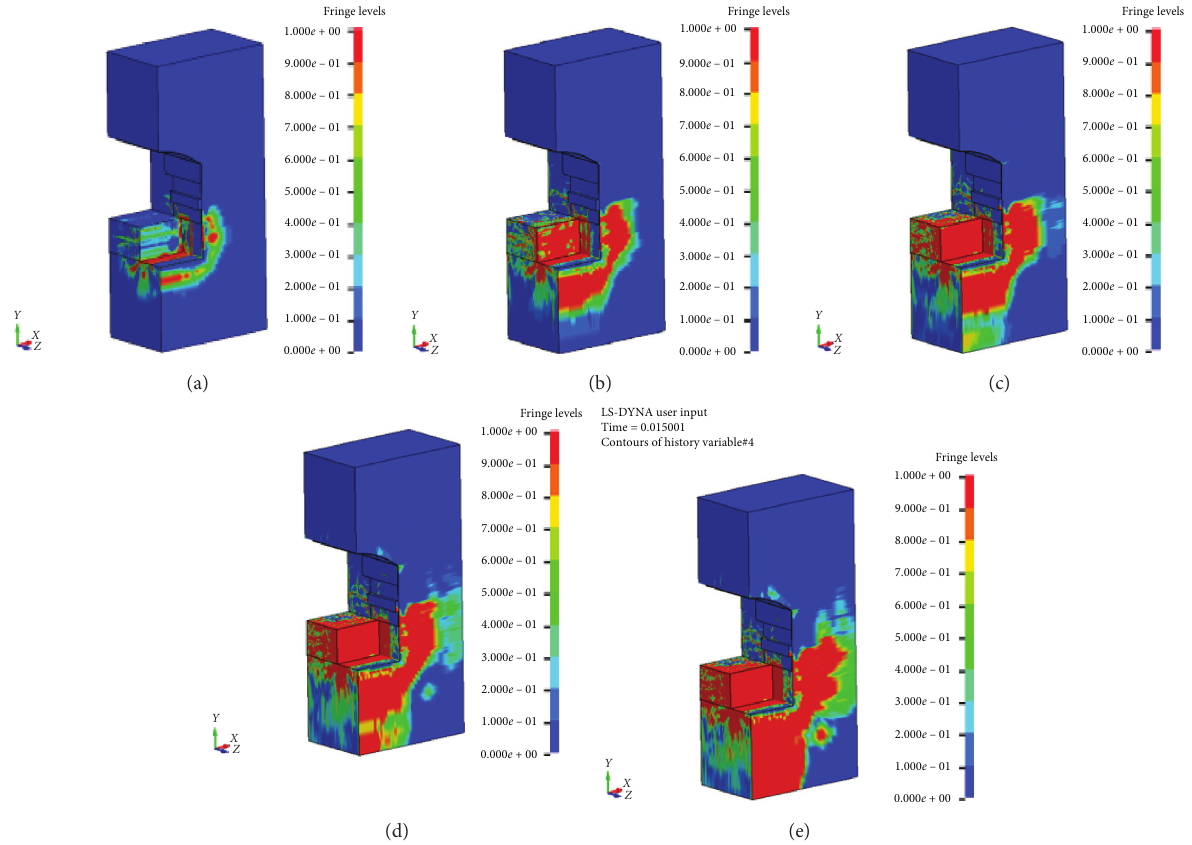
Figure 14: Cumulative damage nephogram of surrounding rock and rock anchor beam concrete under blasting. (a) 3.1 ms, (b) 6.1 ms, (c) 9.1 ms, (d) 12.1 ms, and (e) 15.0 ms.